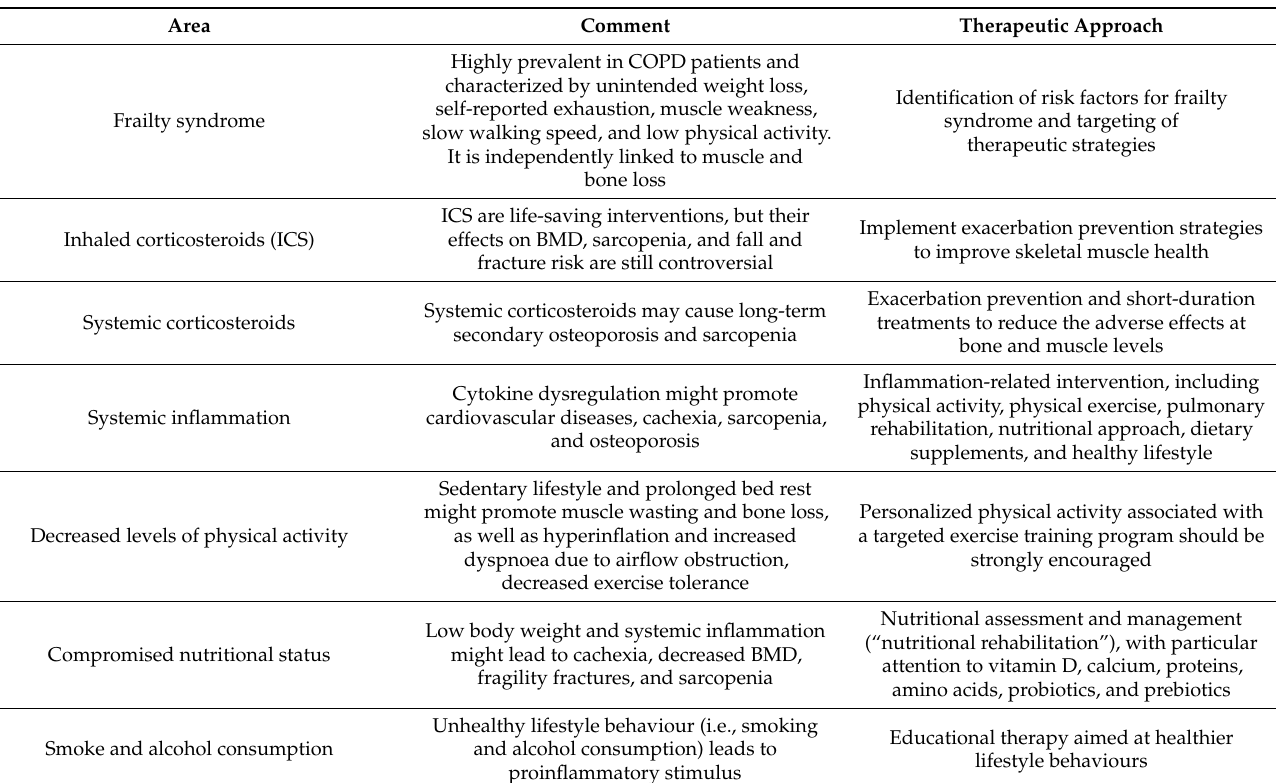
Table 1. TherapeuticapproachesusedinsharedriskfactorsandcomplicationsofCOPDandosteosarcopenia.